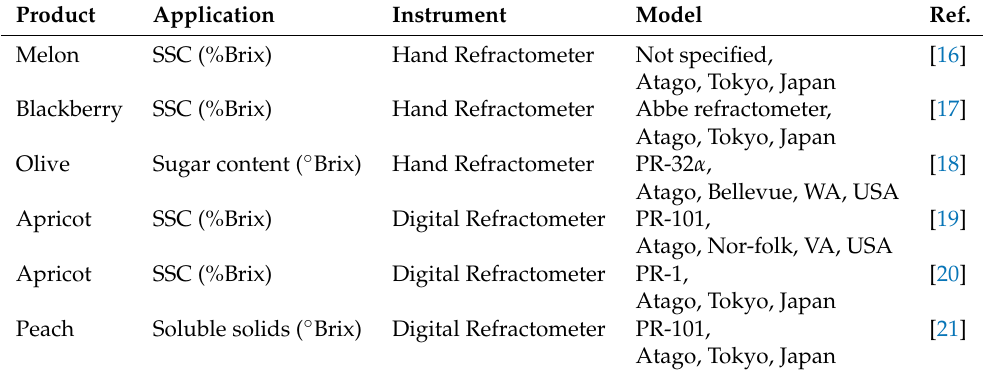
Table 1. Summary of refractometers used in various research of horticulture and agriculture products.